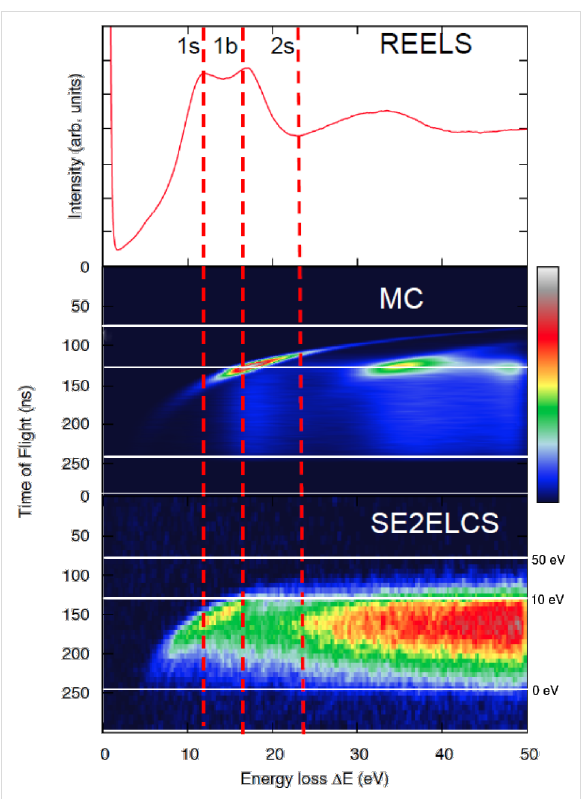
Figure 3: Simulation geometry: 1 keV electrons impinge normally onto the material (Si or Cu); all backscattered electrons are collected.